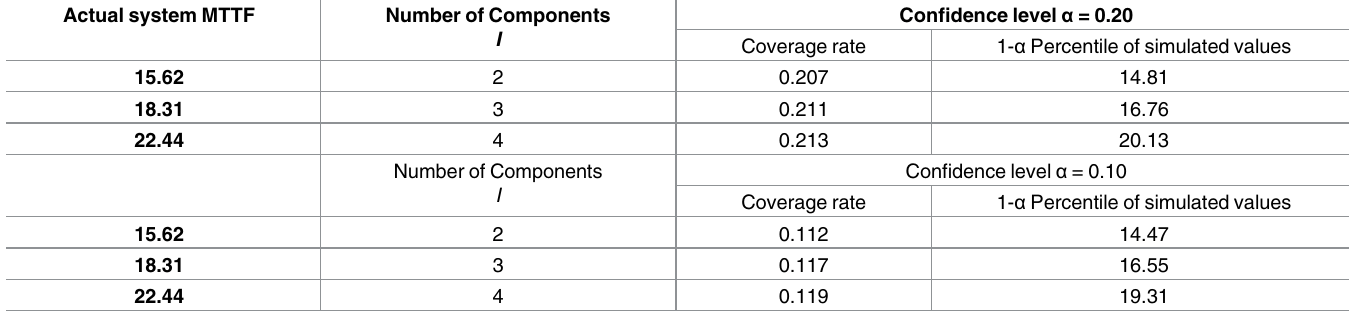
Table 5. Coverage rate of simulations results F (cid:0) 1 distribution. Actual system MTTF